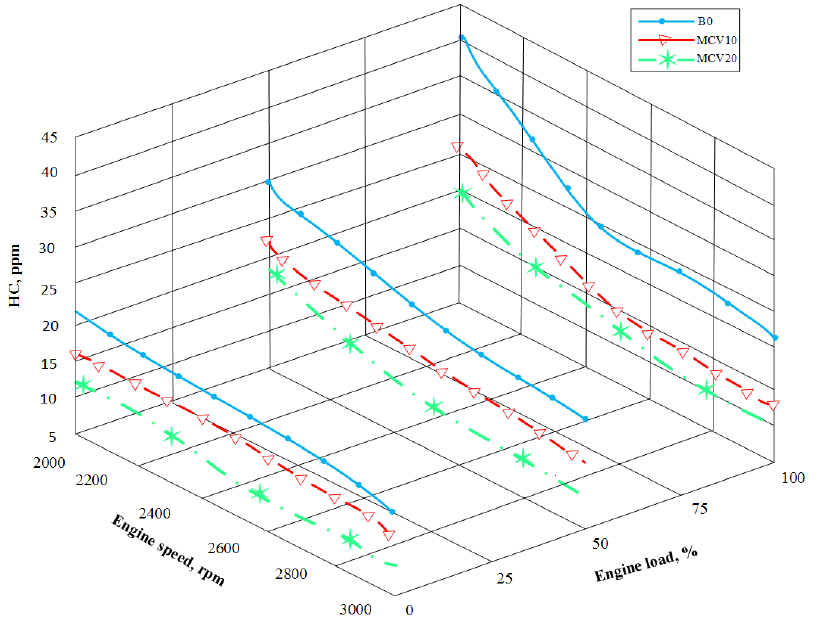
Fig. 5. HC emissions of MCV biodiesel blends at different loads/speeds.